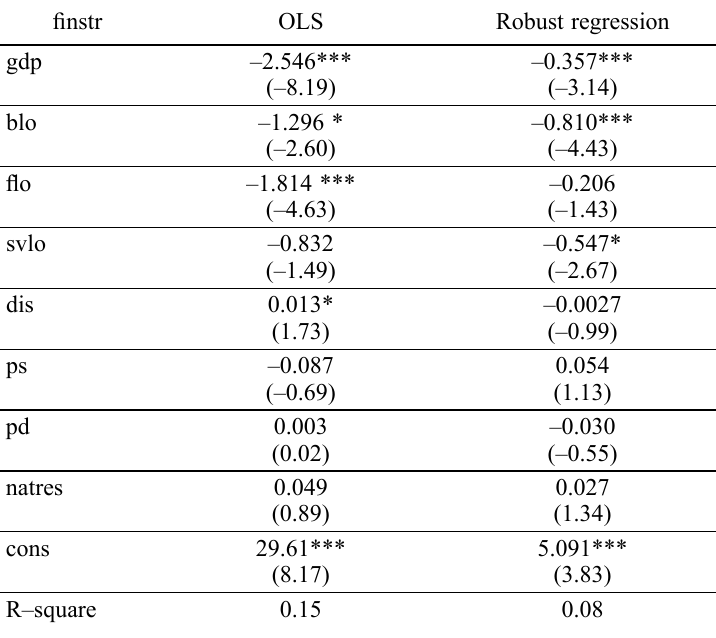
Table 6. Financial structure ratio regression (estimated on OECD samples) finstr OLS Robust regression